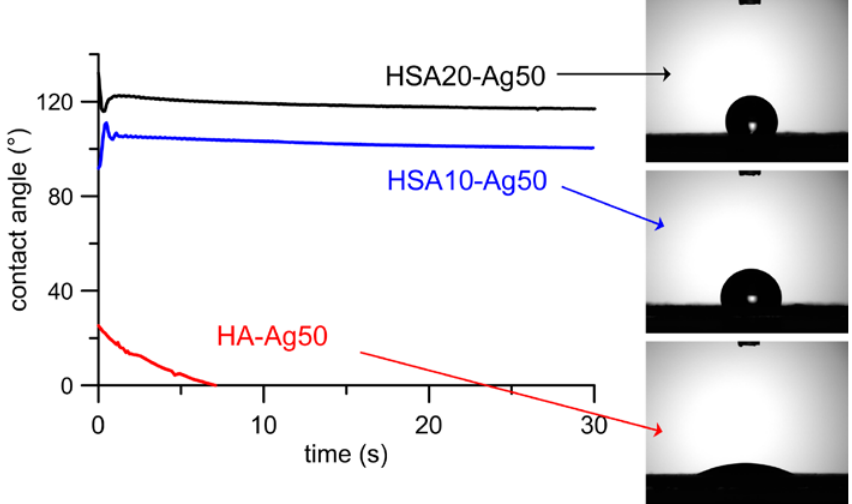
Figure 4. Plots of contact angle values as a function of time. The images of droplets measured after 1 second on different composite materials are shown on the right.